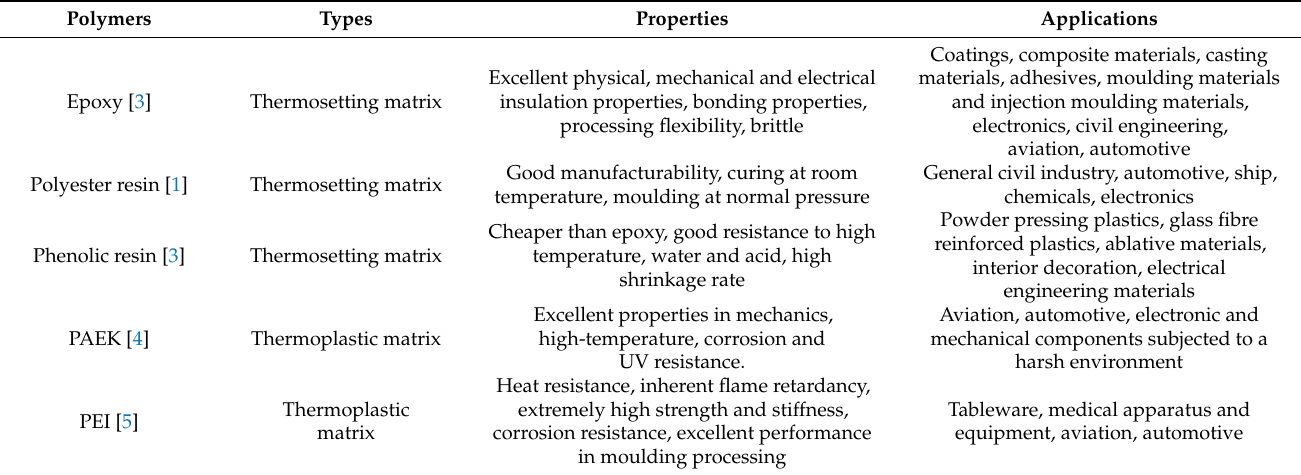
Table 1. Properties of polymer composites.